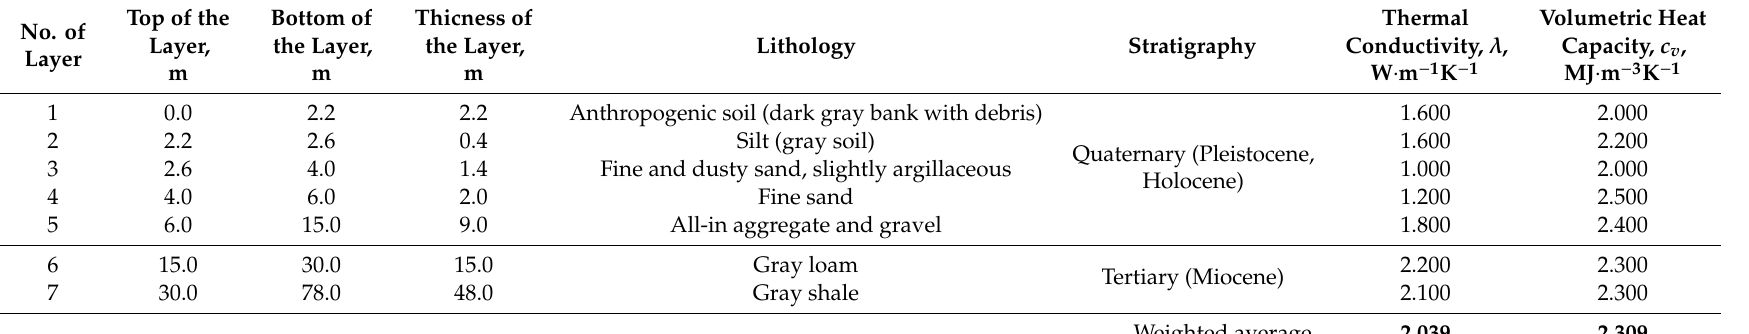
Table 2. Stratigraphic lithological profile of the LG-2a borehole together with selected thermal parameters of rocks [40]. Top of the No. of Layer